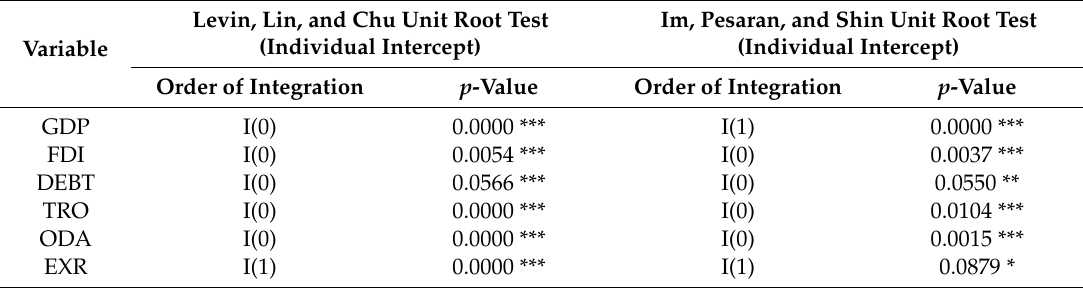
Table 3. LLC and IPS panel unit root tests for upper-middle